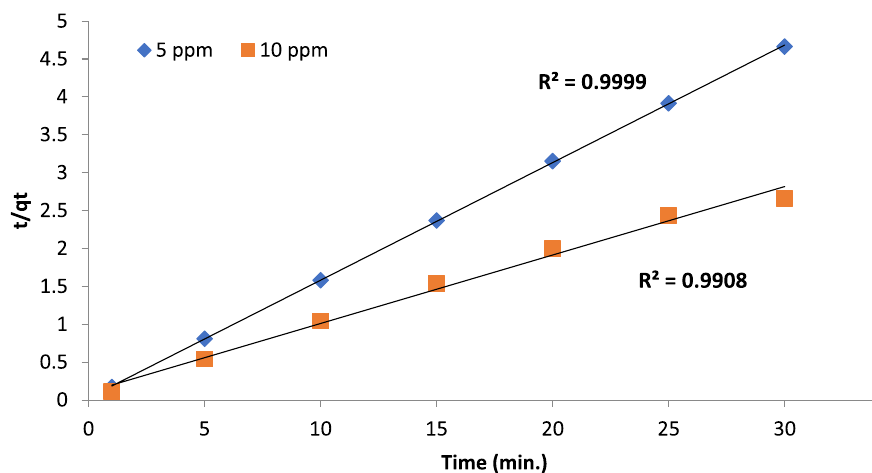
Figure 6. Pseudo-second order model of BF by Gel@GO-F-ZrSiO 4